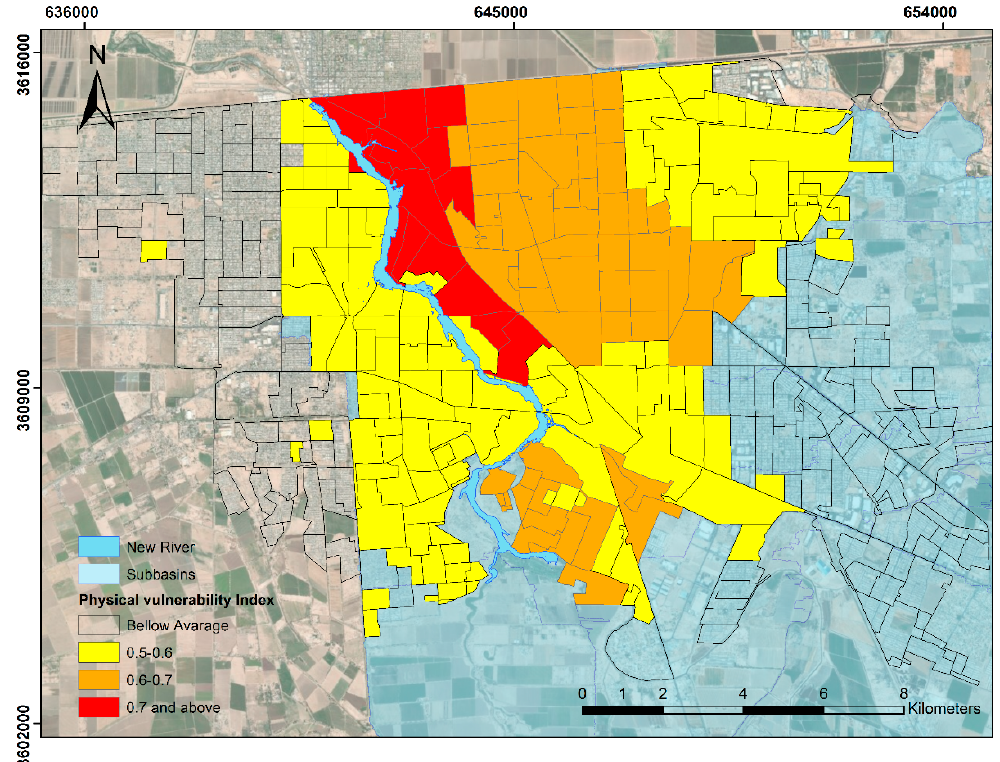
Figure 8. Comparison of the physical vulnerability indicators.